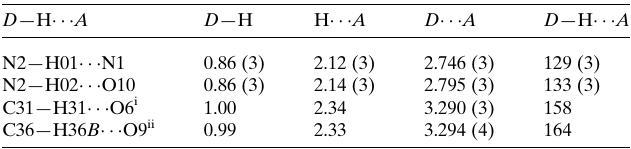
Table 2 Hydrogen-bond geometry (A˚ , (cid:2) ).